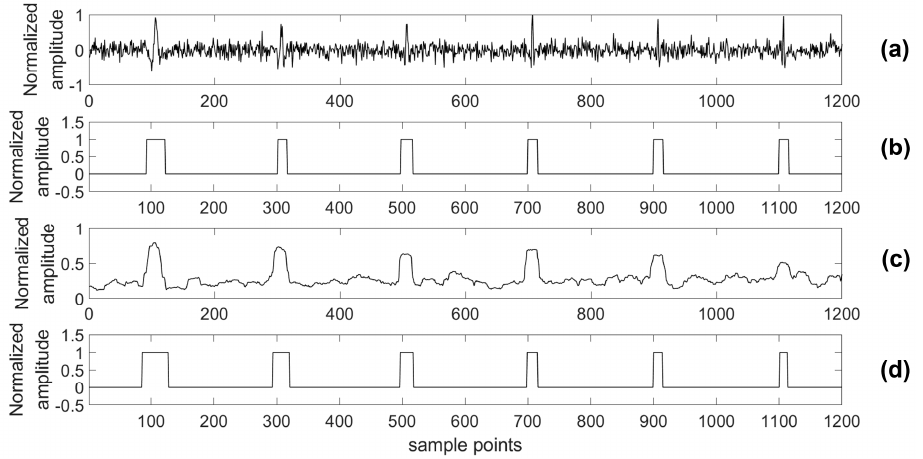
Figure 16. Channel A of test data ( − 10 dB) and its results. ( a ) Test data ( − 10 dB); ( b ) Detection results of the proposed algorithm; ( c ) Detection results of the STA/LTA algorithm; ( d ) The real label.